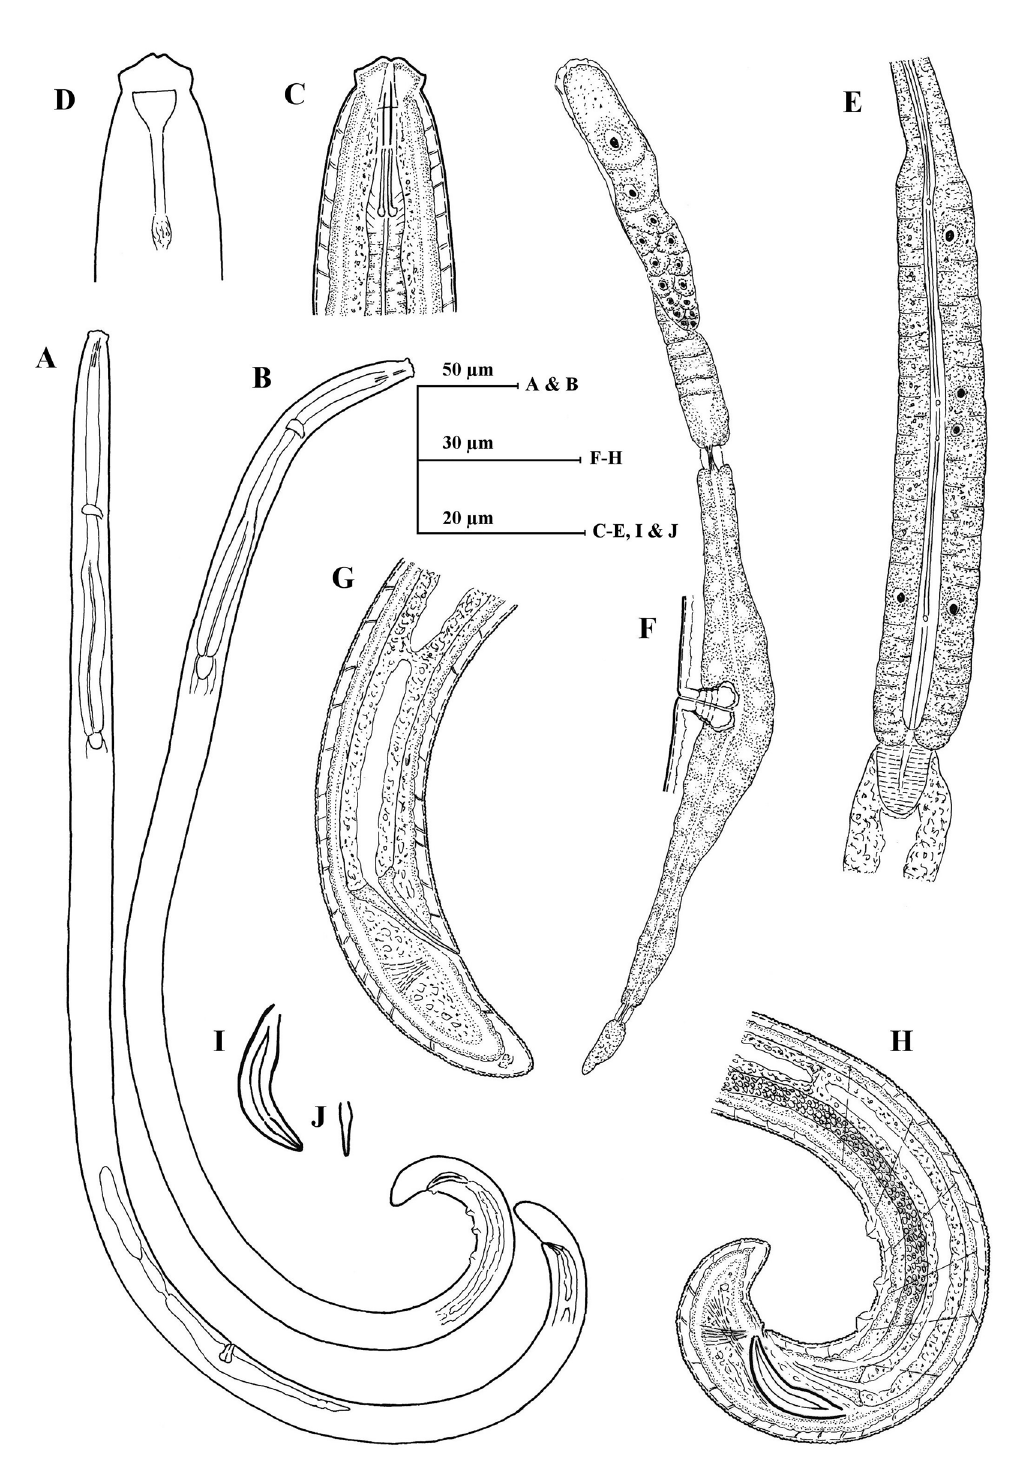
Fig. 7. Tylencholaimus macroamphidius sp. nov. A, C, F–G . Holotype, ♀ (AMU/ZD/NC/ Tylencholaimus macroamphidius /1). B, D, H–J . Paratype 6, ♂ (slide 5). E . Paratype 3, ♀ (slide 3). A . Entire female. B . Entire male. C . Female anterior region. D . Male anterior region showing amphid. E . Female expanded part of pharynx. F . Female genital system. G . Female posterior region. H . Male posterior region. I . Spicule. J . Lateral guiding